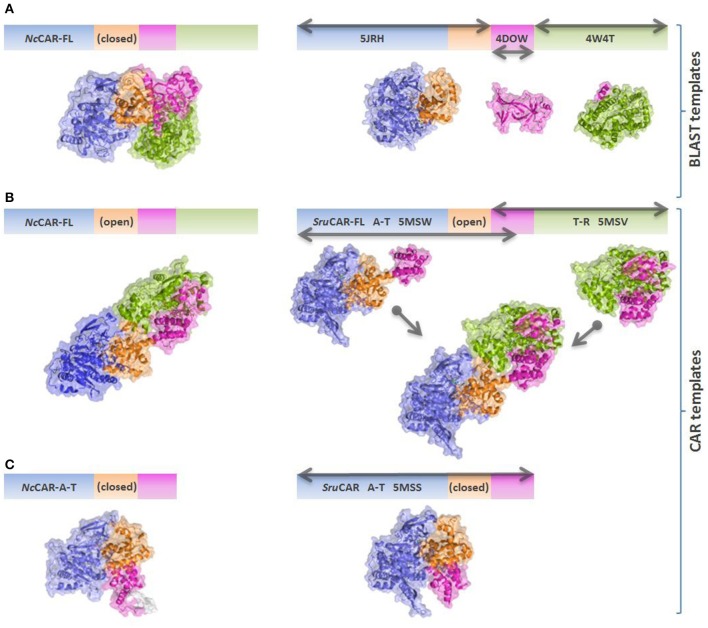
Schematic overview of NcCAR models and templates. Models are colored according to individual domains as in Gahloth et al. (2017). Blue: Acore; orange: Asub; magenta: T-domain; green: R-domain. Gray arrows indicate the parts of the sequence which are covered by the individual templates. (A)
NcCAR full length model based on best BLAST templates (mainly PDB codes 5JRH, 4DOW, and 4W4T). 5JRH: Salmonella enterica acetyl-CoA synthetase (Han et al., 2016); 4DOW: Mus musculus ORC1 BAH domain (Kuo et al., 2012); 4W4T: Stigmatella aurantiaca terminal reductase domain from the myxalamid NRPS MxaA (Barajas et al., 2015). (B)
NcCAR full length model based on the open SruCAR structures, fused together to a full length SruCAR template. (C)
NcCAR A-T-didomain model based on the closed SruCAR A-T-didomain structure (PDB code 5MSS).